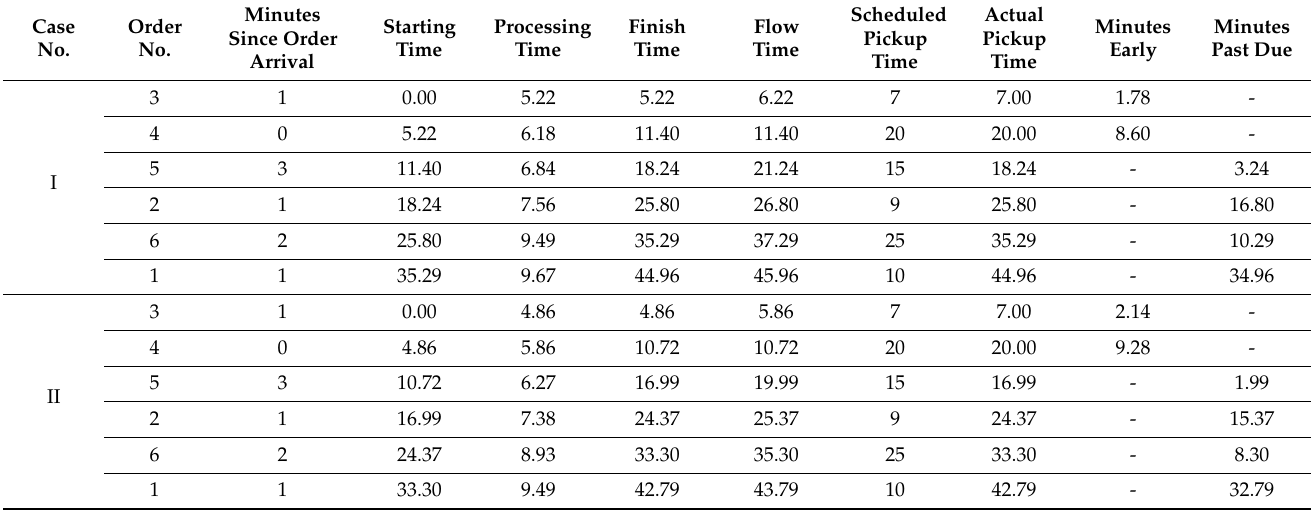
Table 7. Sequence of the orders based on the SPT